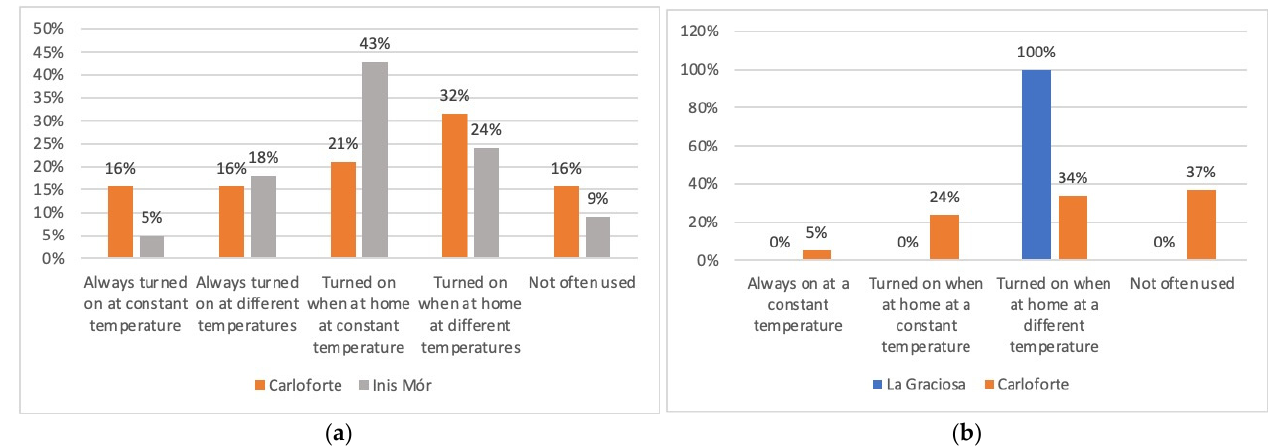
Figure 4. ( a ) Heating system use among respondents in Carloforte and Inis Mór islands; ( b ) Cooling system use among respondents in La Graciosa and Carloforte islands.